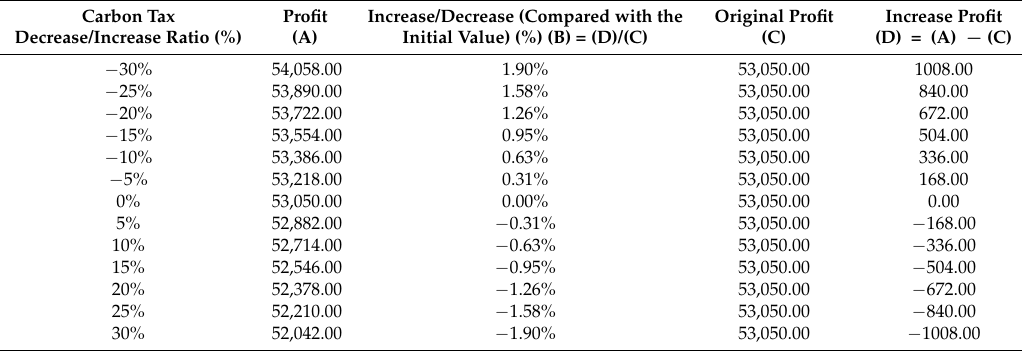
Table 6. Sensitivity analysis on the carbon tax of model 2.